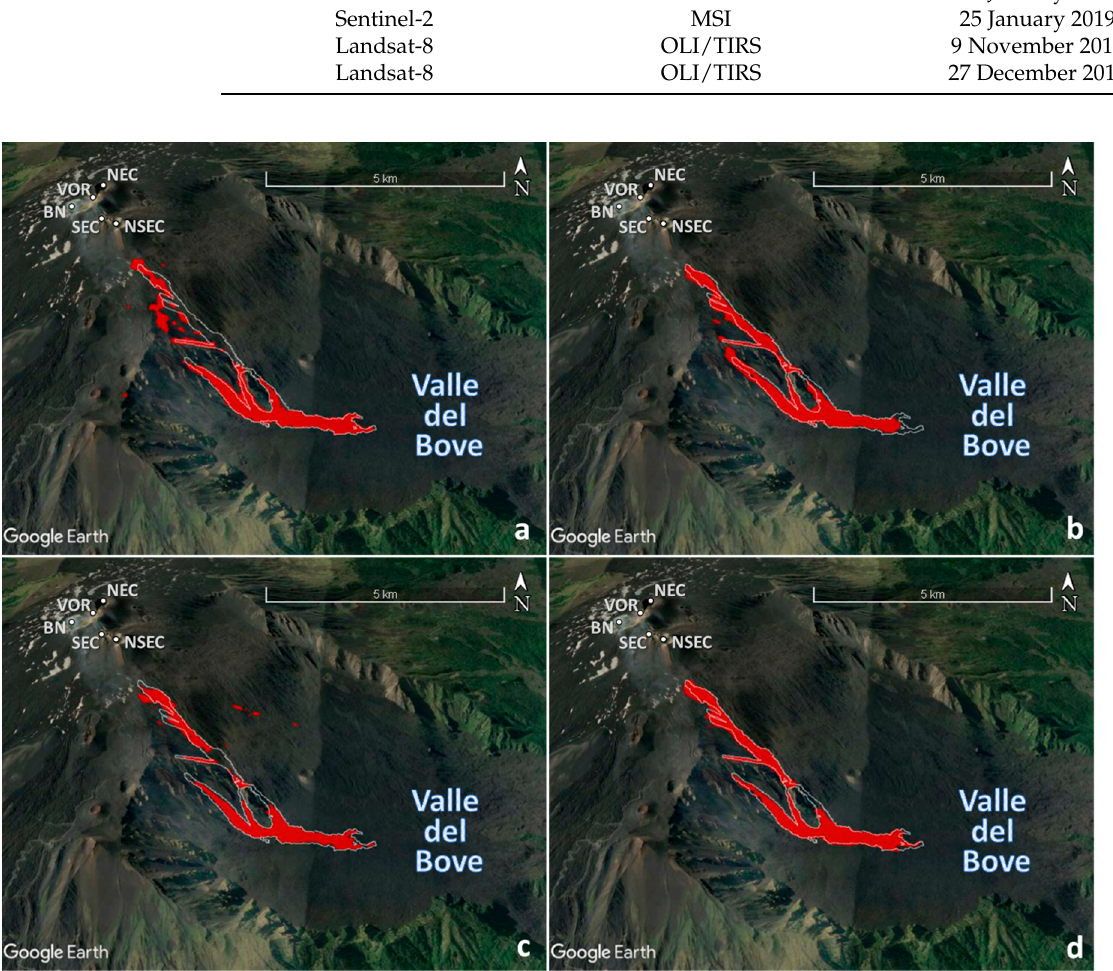
Figure 4. Classifiers outcomes for the 2018 Etna eruption. ( a ) K-mean outcome for the S1 data; ( b ) SVM outcome for the S2 data; ( c ) SVM outcome for the L8 data; ( d ) SVM outcome for the fused data. North-East Crater (NEC), Voragine (VOR), Bocca Nuova (BN), South-East Crater (SEC), and New South-East Crater (NSEC) are the summit craters of Etna. Valle del Bove is the large depression on the eastern flank of the volcano. This figure was generated using Google Earth.